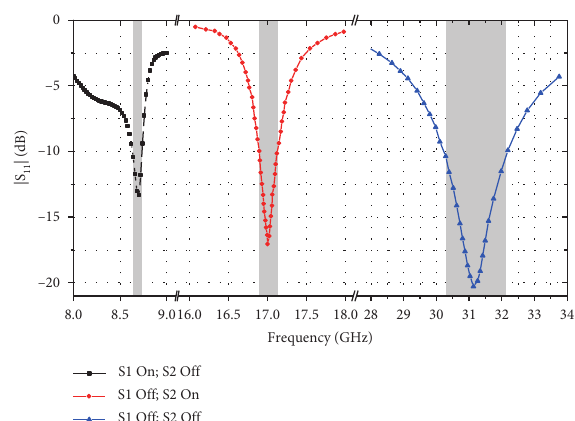
Figure 6: Simulation results of the reflection coefficient of FRA integrated RF MEMS switches.